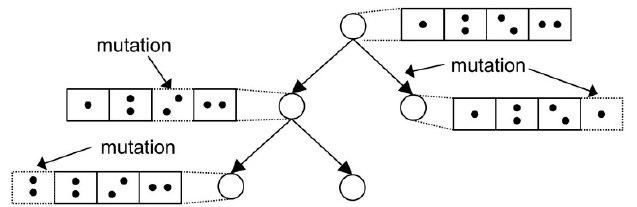
Figure 11. Tree structure of evolutionary EMCTS. Nodes represent action sequences and edges represent mutations of a single action. Repairs may be necessary if the mutations lead to invalid sequences of actions. An evaluation function is used instead of a rollout after each node expansion.